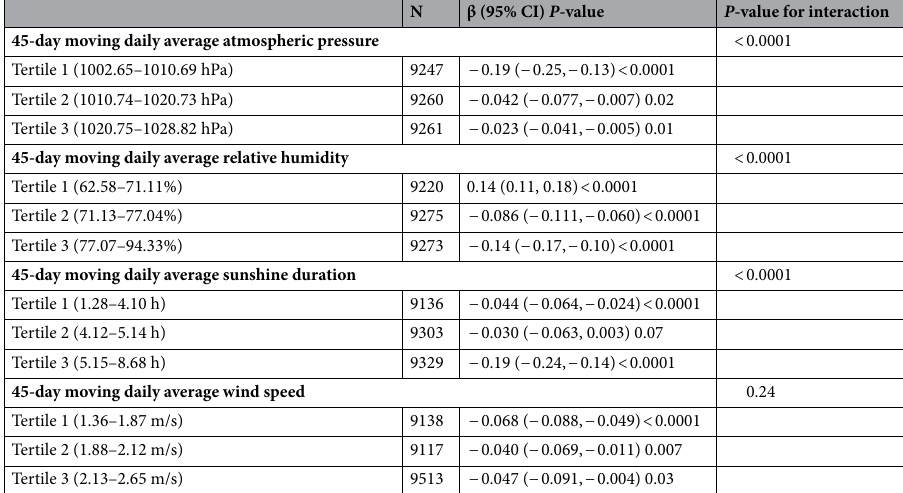
N β (95% CI) P -value P -value for